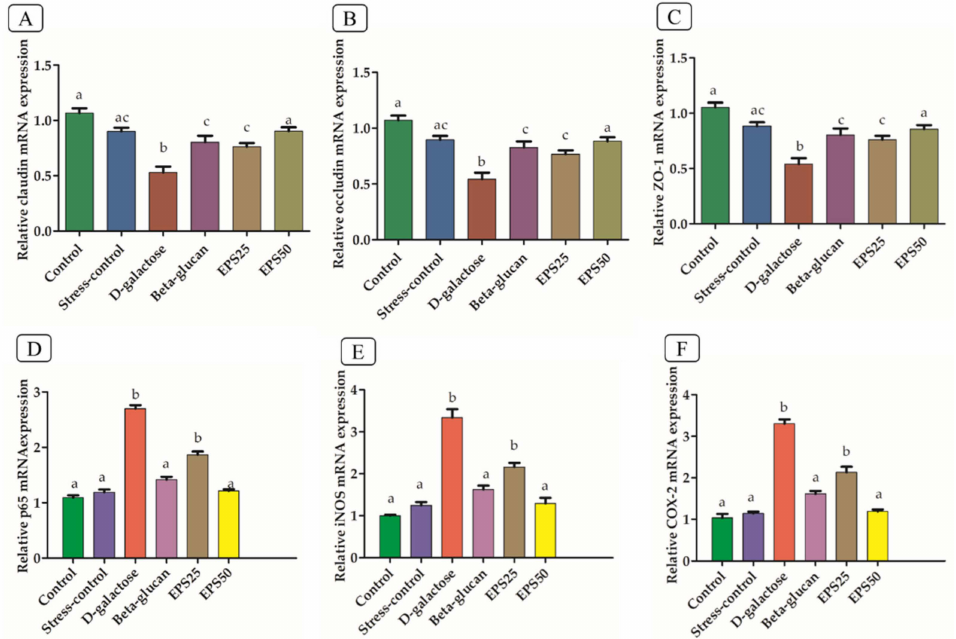
Figure 4. Effects of EPSRam12 on real-time quantitative PCR expression of tight-junction mRNA in colon and pro-inflammatory mRNA in brain of D-galactose-induced mice. ( A ) Claudin-1 mRNA, ( B ) Occludin mRNA, ( C ) ZO-1 mRNA, ( D ) p65 mRNA, ( E ) iNOS mRNA, and ( F ) COX-2 mRNA. Values are means ± SEMs. Data were presented as mean ± SEM. Data were analyzed using One- way ANOVA with Bonferroni post-test. Values with dissimilar superscript alphabets (a–c) indicate significant differences ( p < 0.05) among the treatment